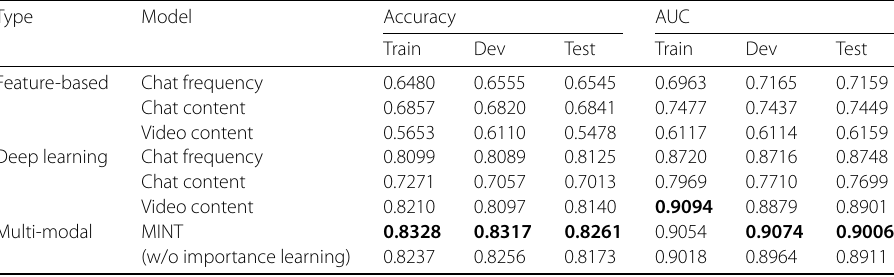
Table 6 Evaluation result for each model